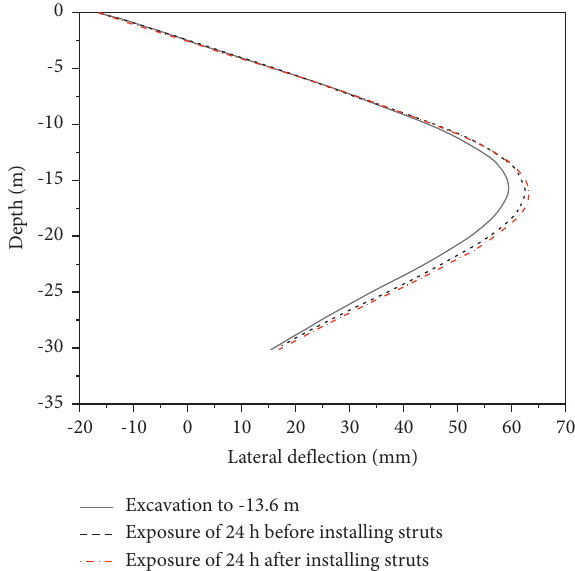
Figure 10: Comparison of lateral deflections of retaining pile between different cases in terms of exposure time, modified from